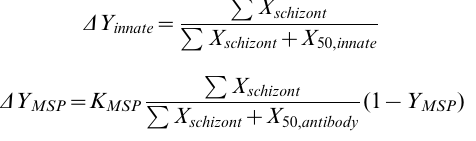
Supporting Information Table S1 Biological input parameters of the model.